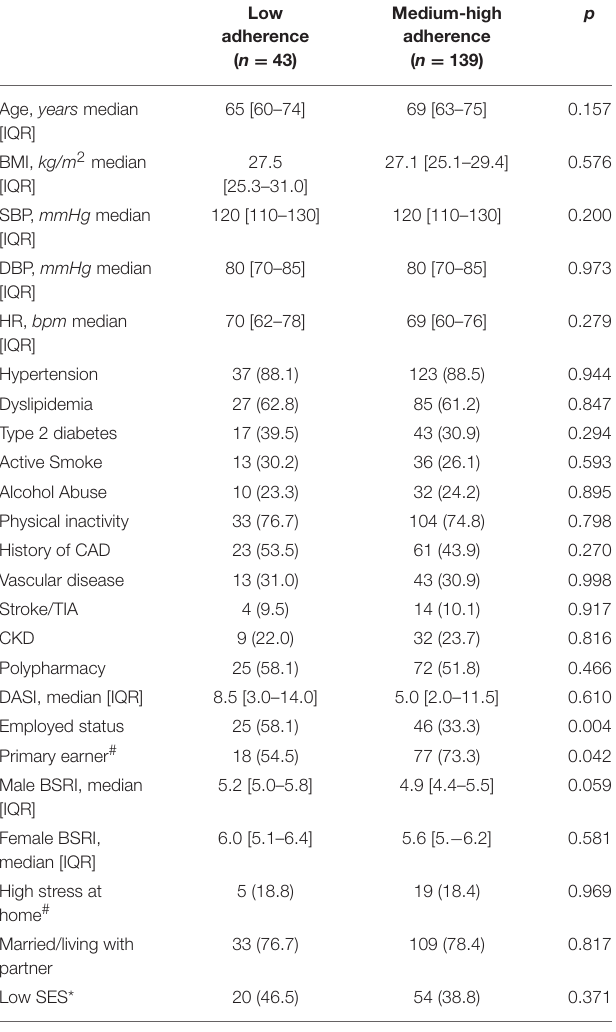
TABLE 4 | Clinical and gender-related factors in women according to pre-admission medication adherence.